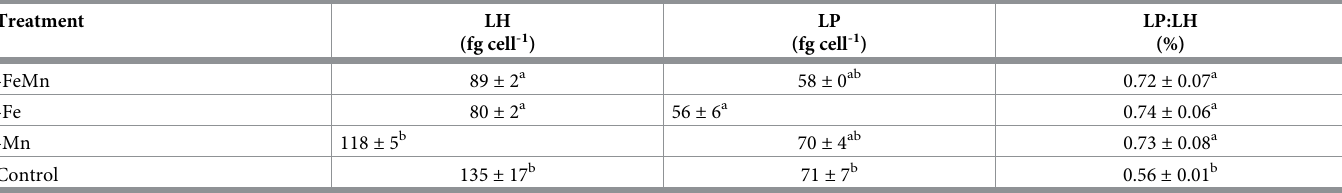
Table 3. Cellular concentrations of light-harvesting (LH: sum of chlorophyll a , chlorophyll c 2 , and fucoxanthin) and light-protective pigments (LP: sum of diadi- noxanthin and diatoxanthin) as well as the ratio of light-protective to light-harvesting pigments (LP:LH) were determined in C . debilis grown in naturally FeMn- poor Antarctic seawater (-FeMn) and to which additions of either Mn alone (-Fe), Fe alone (-Mn) or both (control) were given. Values represent the means ± SD (n = 3). Different letters indicate significant differences between treatments ( p <